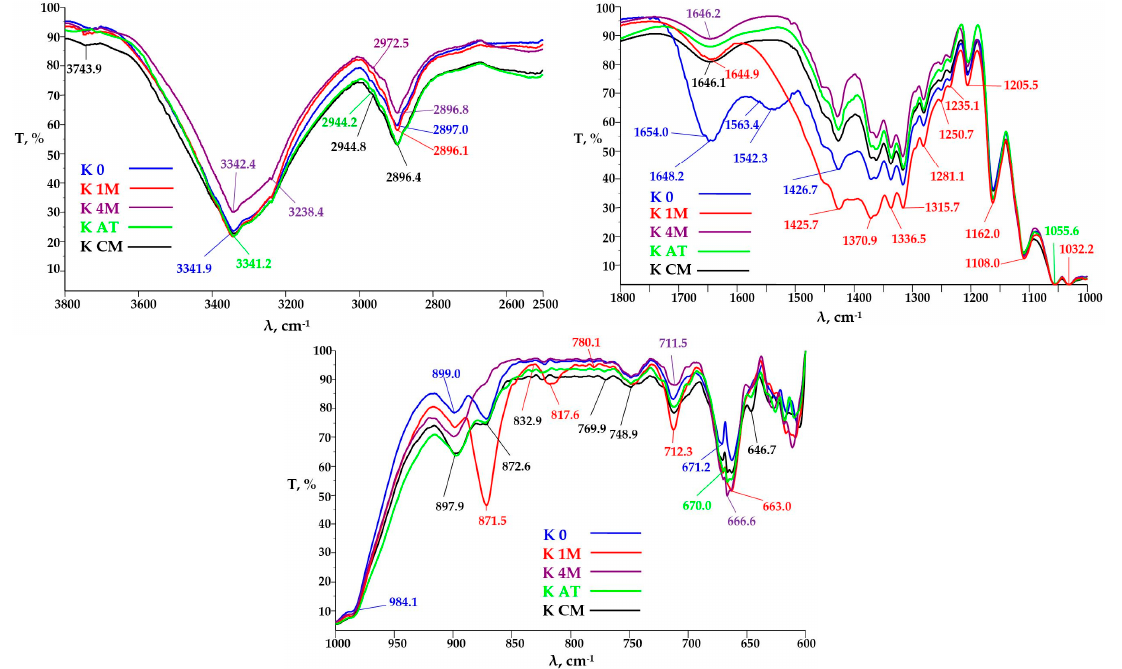
Figure 7. Fourier-transform infrared spectroscopy (FTIR) spectra of KM before and after purification and light mechanical treatments: K_0 = initial KM; K_4M = KM washed with 4 M NaOH; K_AT = K_4M after atomization.